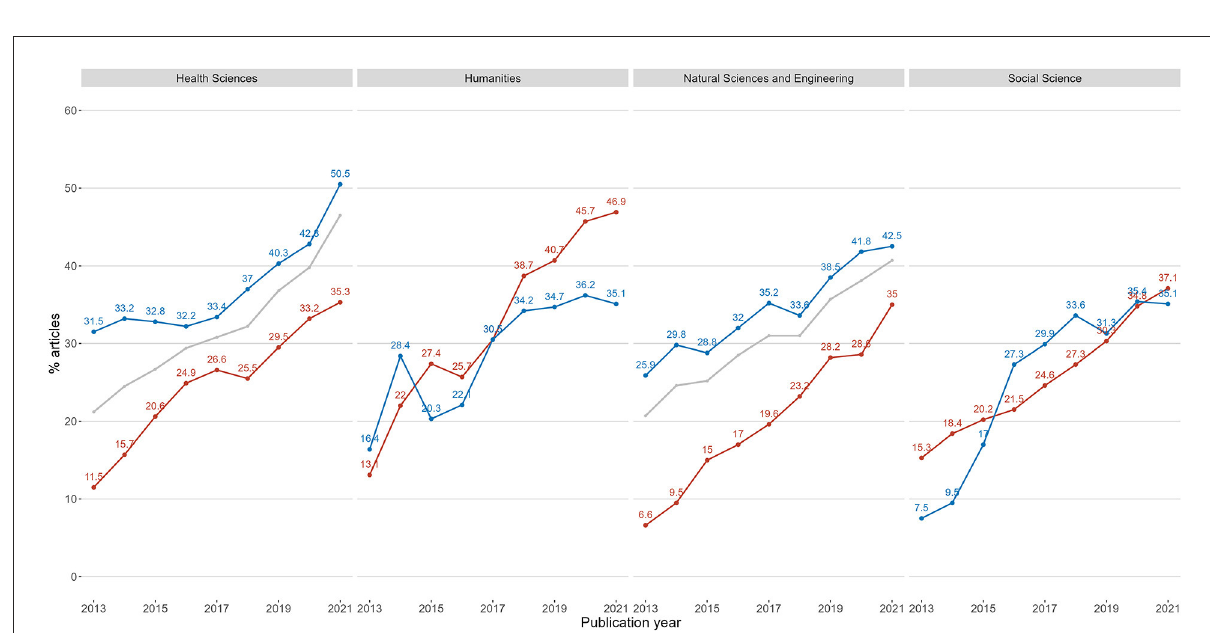
- disciplines (within each of four research areas) without the